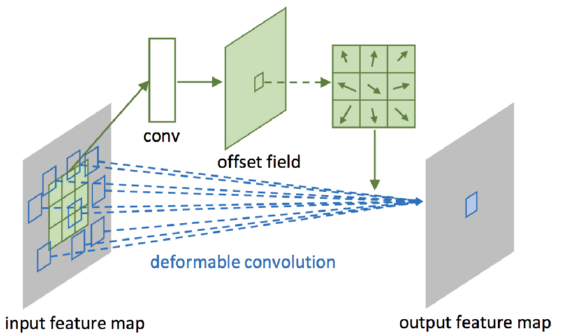
Figure 8. Architecture of 3 × 3 Deformable Convolution. Image is obtained from